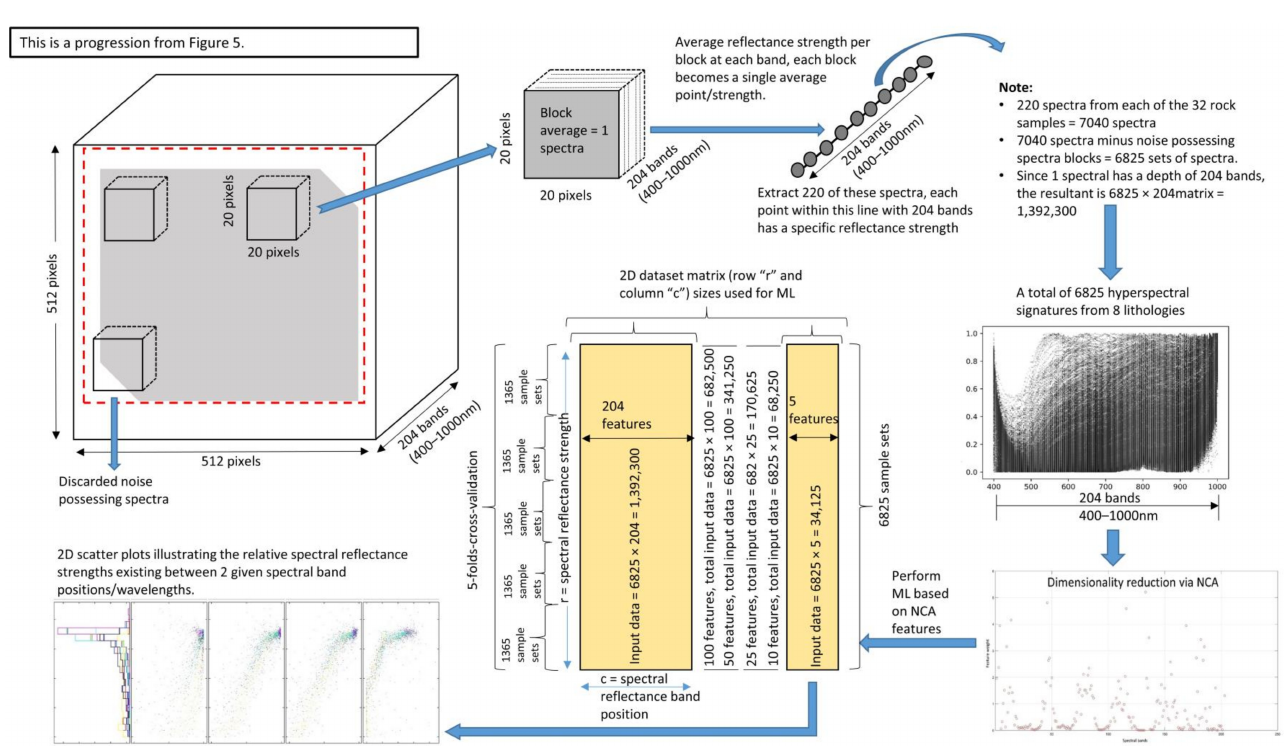
Figure A1. Summary of rock spectral reflectance strength data accumulation and preprocessing prior to dimensionality reduction via Neighbourhood Component Analysis and Machine Learning (a continuation from Figure 5).